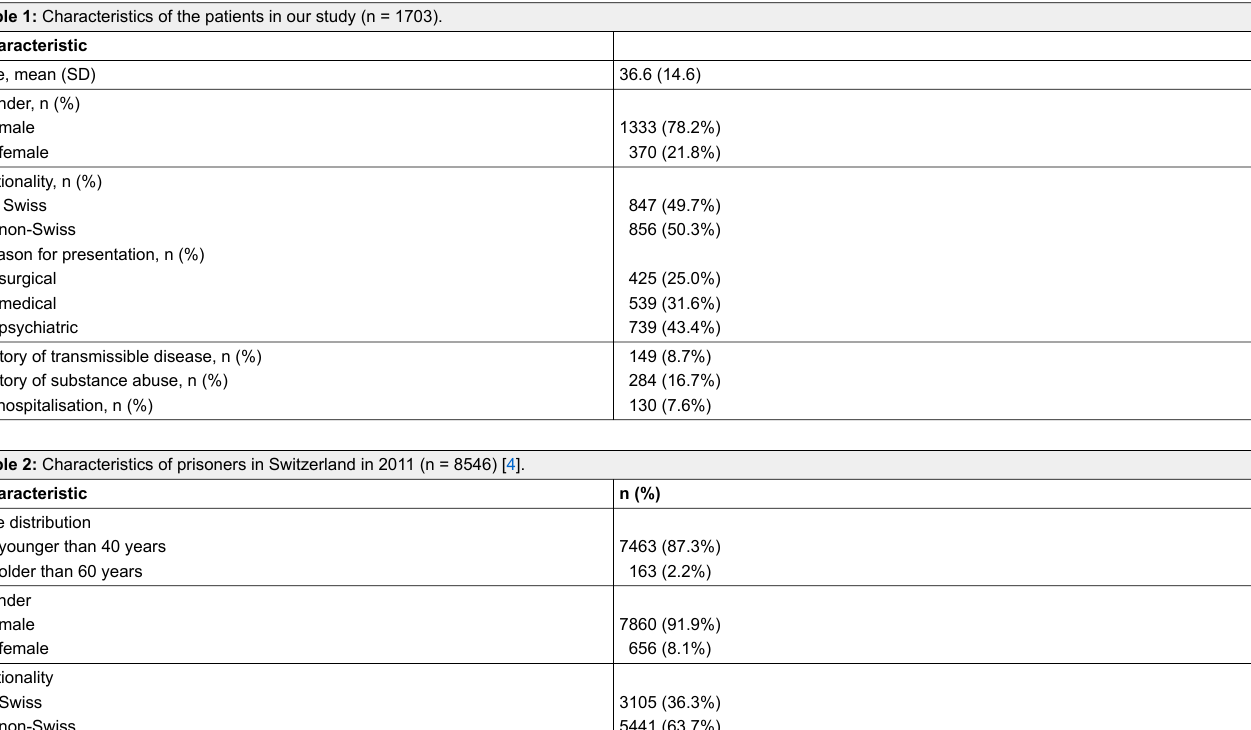
Table 1: Characteristics of the patients in our study (n = 1703). Characteristic